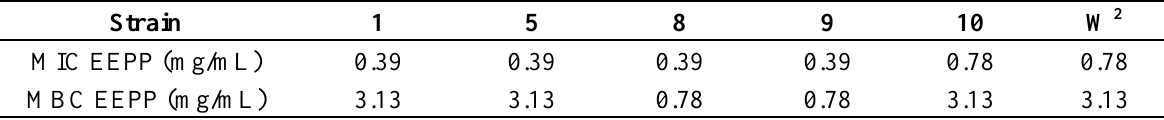
Table 3. Susceptibility of S. aureus MRSA strains to EEPP (MIC and MBC values in mg/mL).